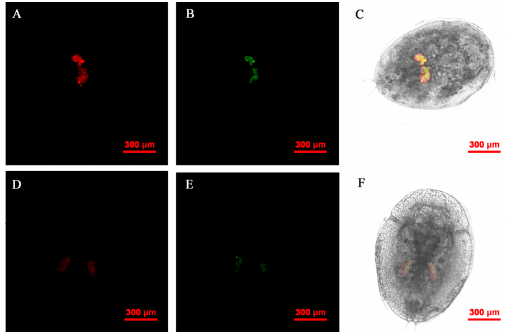
Figure 8. FISH visualization of Wolbachia and Rickettsia in nymph stages of B. tabaci . Localization of symbiotic bacteria Rickettsia (red) and Wolbachia (green) in nymph stages of B. tabaci . Rickettsia fluorescence ( A , D ) and Wolbachia fluorescence ( B , E ) are displayed in dark field; W olbachia and Rickettsia fluorescence ( C , F ) is displayed in bright field.